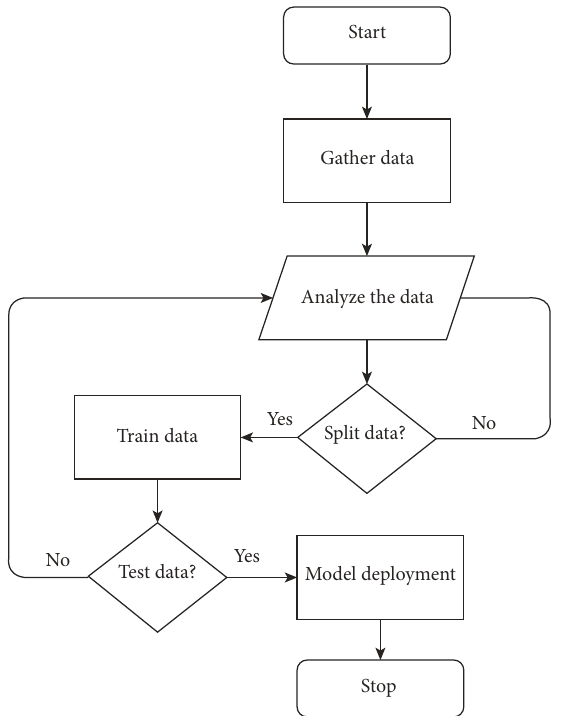
Figure 4: Flowchart representation of deep learning